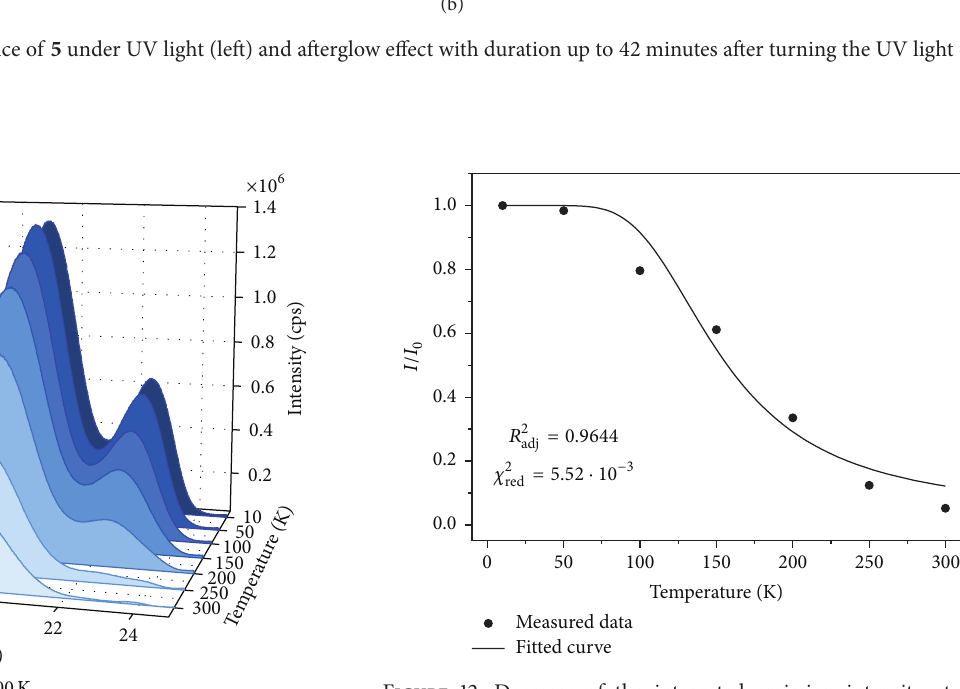
Figure 12: Decrease of the integrated emission intensity at 22 = 27 620 cm −1 ) of 5 with increasing temperature. The 470 cm −1 ( ̃𝜐 ex solid line is a fit to